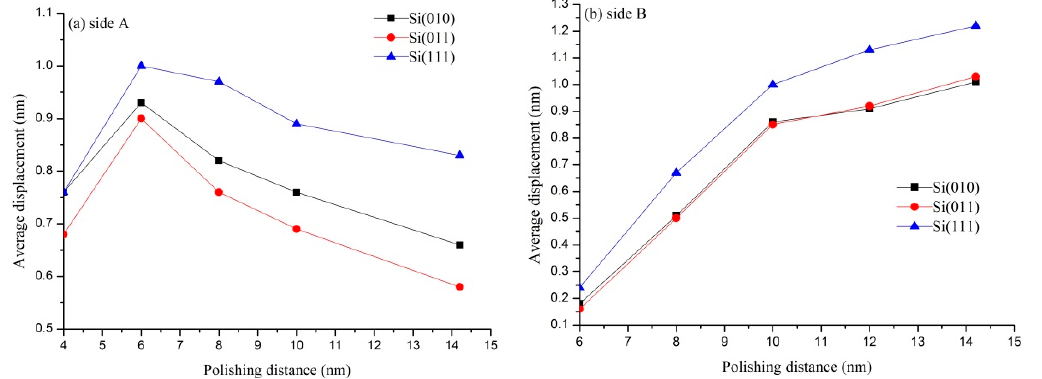
Figure 7. Average displacement of A and B.